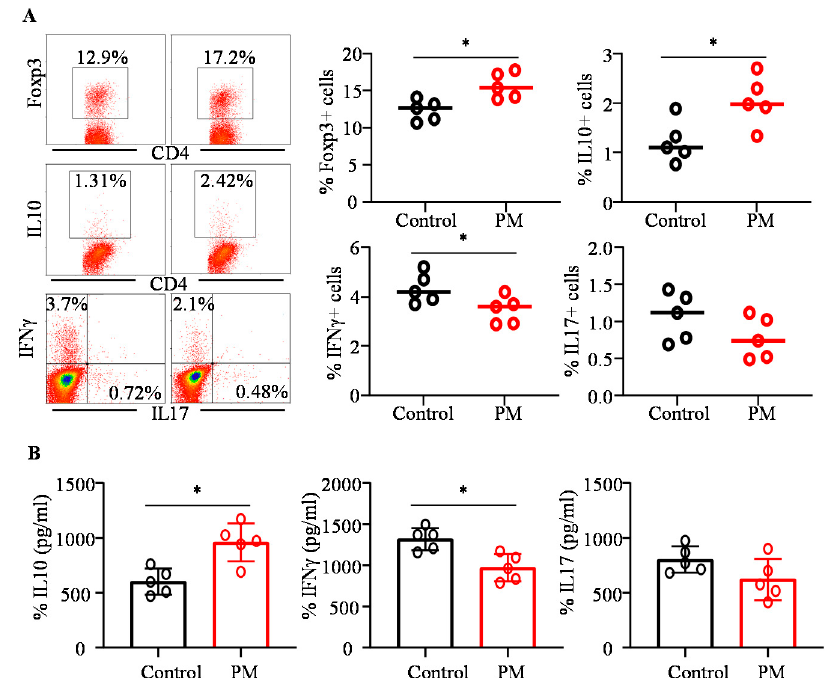
Figure 6. Impact of pre-treatment with PM on immune cells. B6 mice were treated as depicted in Figure 5A. ( A ) MLN cells were stained for Foxp3 and subjected to FACS analysis. Cells were also activated using PMA / Ionomycin in the presence of Brefeldin A for 4 h and subjected to intracellular staining for cytokines and analyzed by FACS. CD4 + population was gated for determining cell frequencies. Representative FACS plots (left panel) and mean ± SD frequencies of cells positive for indicated specific factors, 5 mice / group tested individually in duplicate, (right panel) are shown. ( B ) Immune cells were enriched from single cell suspension of colon tissue and cultured in the presence of anti-CD3 antibody for 24h and the spent media were subjected to Luminex technology-based multiplex assay. Mean ± SD values of concentrations of indicated cytokines produced by cells from 5 mice / group tested individually are shown. p -values by Mann–Whitney test. * p < 0.05.